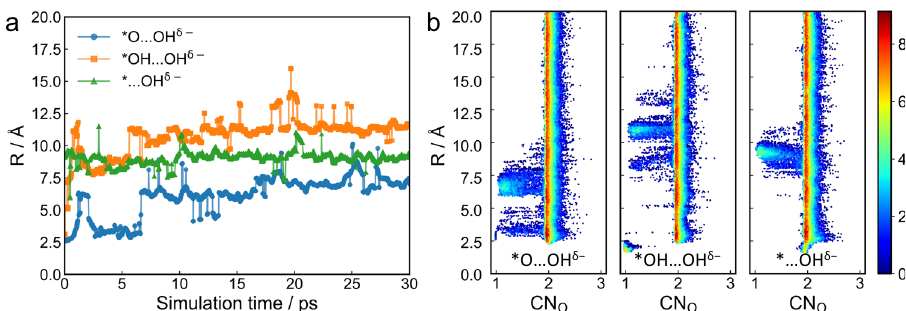
Fig. 3 Spatial evolution and equilibrium distribution of the pseudo-adsorption species from AIMD. a The z coordinate of the O in dissociated OH δ − relative to that of the Fe single site (denoted as R) in *O … OH δ − , *OH … OH δ − , and * … OH δ − intermediates during the 30 ps AIMD simulations. b Probability density distribution of CN O as a function of R, from the three equilibrated AIMD trajectories. The scatter markers are colored by the frequency of occurrence (in logarithm scale) according to the color bar on the right. CN O denotes the coordination number of O